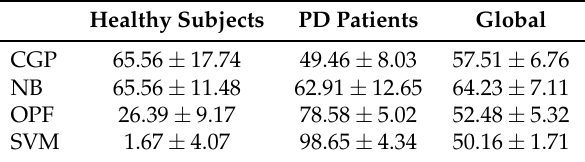
Table 4. Recognition rates per class and global accuracy ( mean ± sd ) for the spiral dataset.